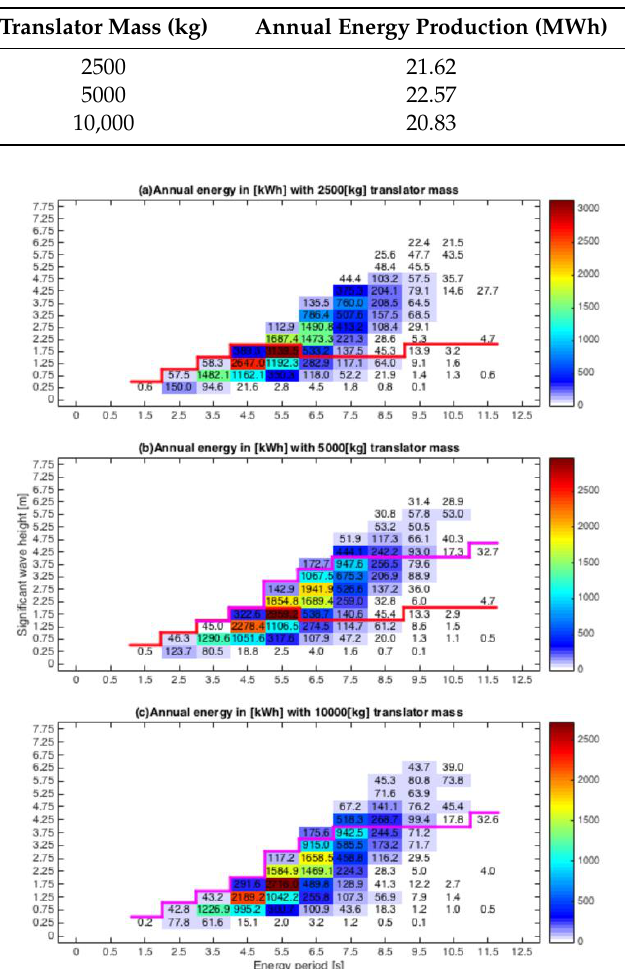
Table 4. Annual energy production with three translator masses at Test Site 6.